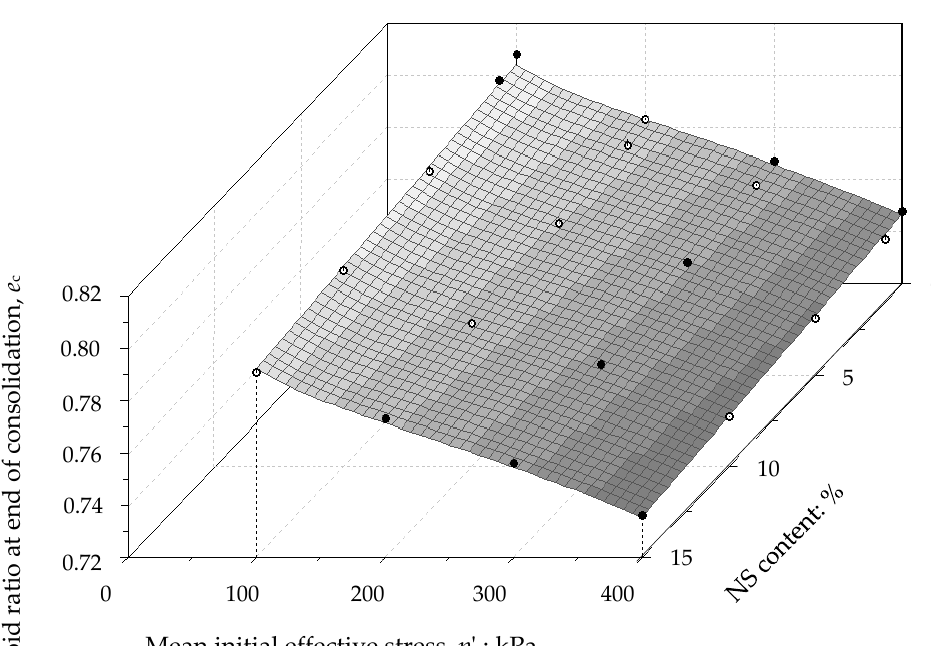
Figure 4. Variation of packing state with nano-silica content in terms of post-consolidation .